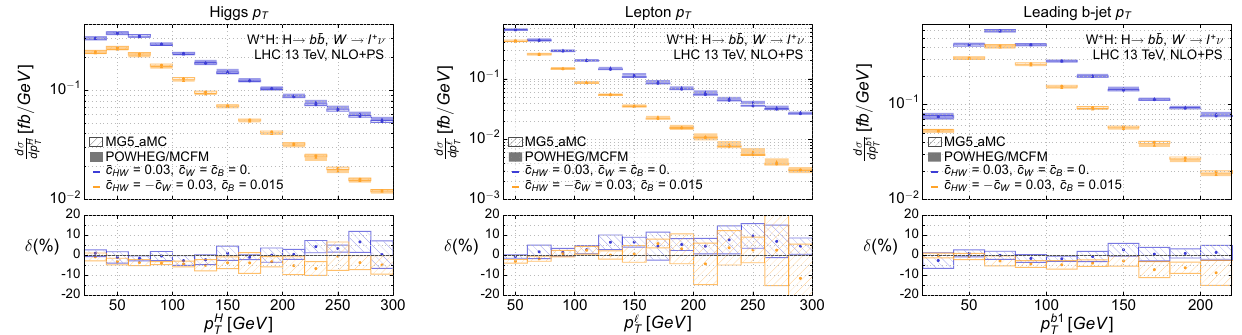
Fig. 6 W + H differential distributions at NLO+PS in the MG5_aMC and MCFM/ Powheg framework